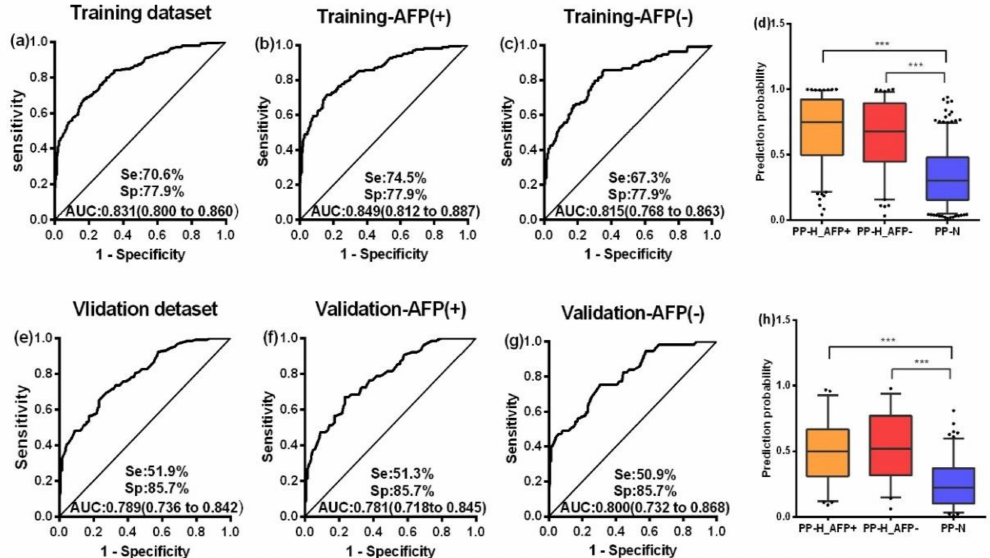
Figure 4. ROC curves of the PP value in the training dataset ( a ), validation dataset ( e ), AFP ( + ) group and AFP ( − ) group of the training dataset ( b , c ), and those of the validation dataset ( f , g ). Box plots present the levels of the PP value among the AFP ( + ) group and AFP ( − ) group and NC group in the training dataset ( d ) and validation dataset ( h ). Se, sensitivity; Sp, specificity; AUC, area under the receiver operating characteristic curve, 95% CI of AUC in brackets. PP, the prediction probability of logistic regression for HCC; H, hepatocellular carcinoma. Lines on boxes are in the order of 95, 75, 50, 25 and 5 quantiles from top to bottom; Whiskers indicate points greater than 95% quantile and less than 5% quantile; *** p <